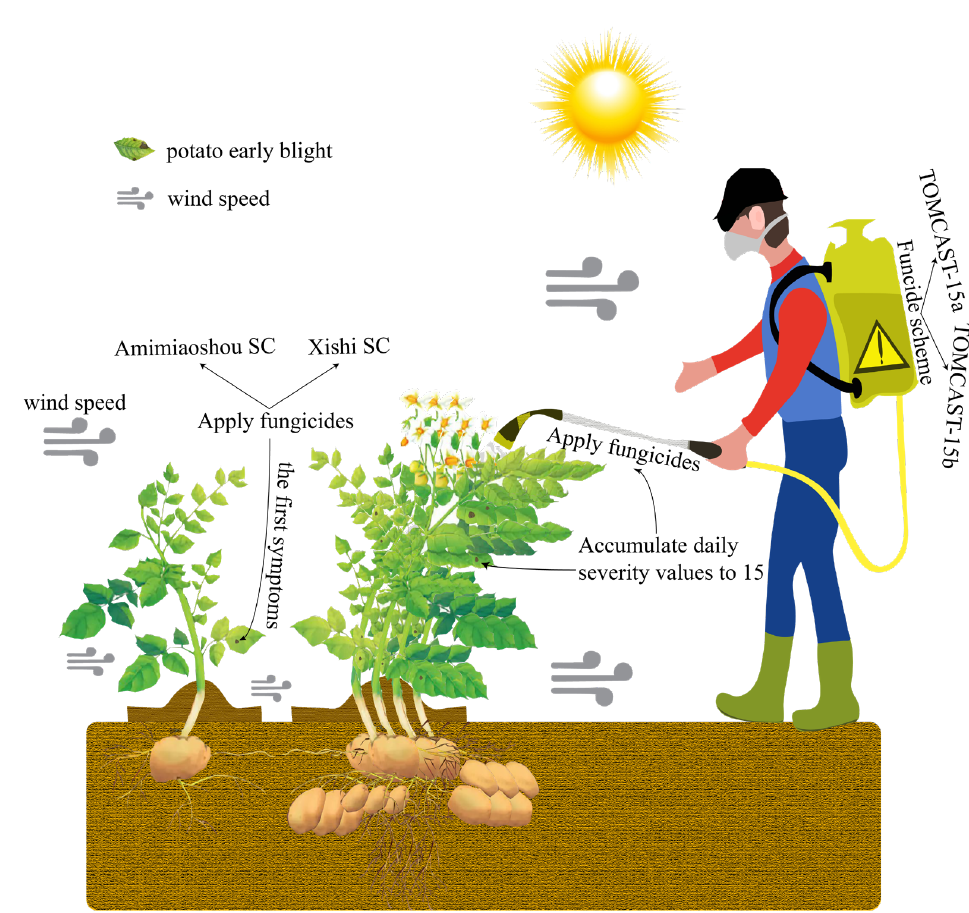
Figure 5. Flow chart of different application schemes for potato early blight. Table 5. Description of the fungicide schedule used to control early blight during the field trial from 2020 to